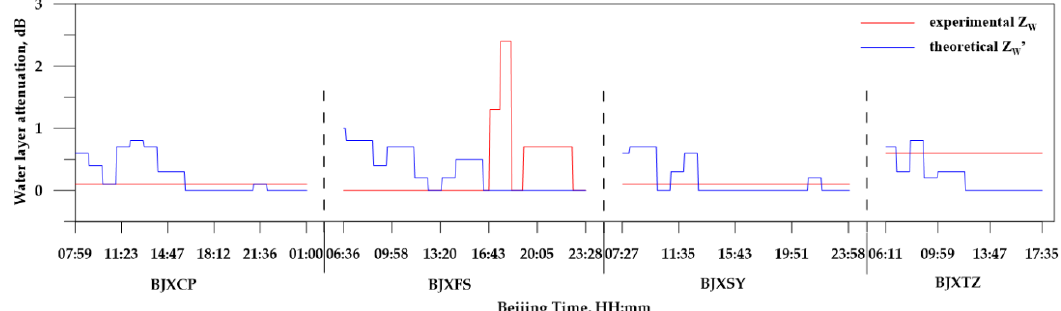
Figure 6. Temporal variations of experimentally estimated Z W through using static reflectivity integrated correction (RIC) (an hour) and of theoretically calculated Z W ’ through using rainfall rate R integrated correction (RIC) (an hour) and of theoretically calculated Z W (cid:48) through using rainfall rate R collected at BJXCP, BJXFS, BJXSY, and BJXTZ sites in the event on 20 July 2019. collected at BJXCP, BJXFS, BJXSY, and BJXTZ sites in the event on 20 July